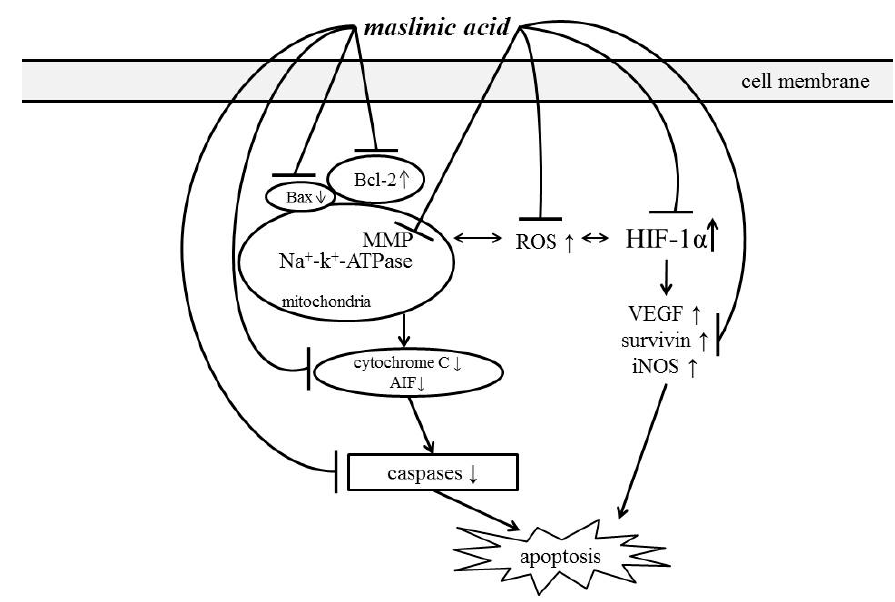
Figure 8. Schematic diagram for cytotoxic effects of maslinic acid toward A549